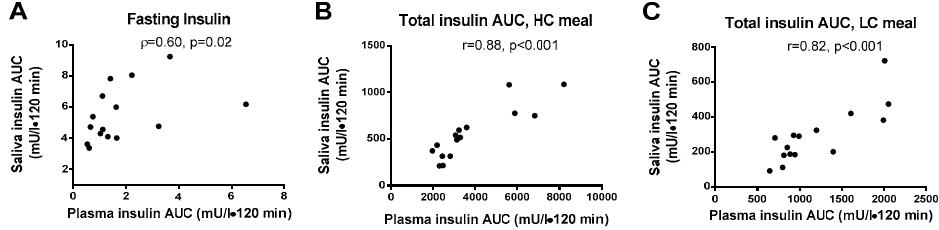
Figure 3. Two-hour plasma glucose responses to low-carbohydrate (LC) and high-carbohydrate (HC) breakfast meals in normal weight (NW) and overweight/obese (OO) participants. ( A ) Plasma glucose in NW participants; ( B ) Plasma glucose in OO participants.